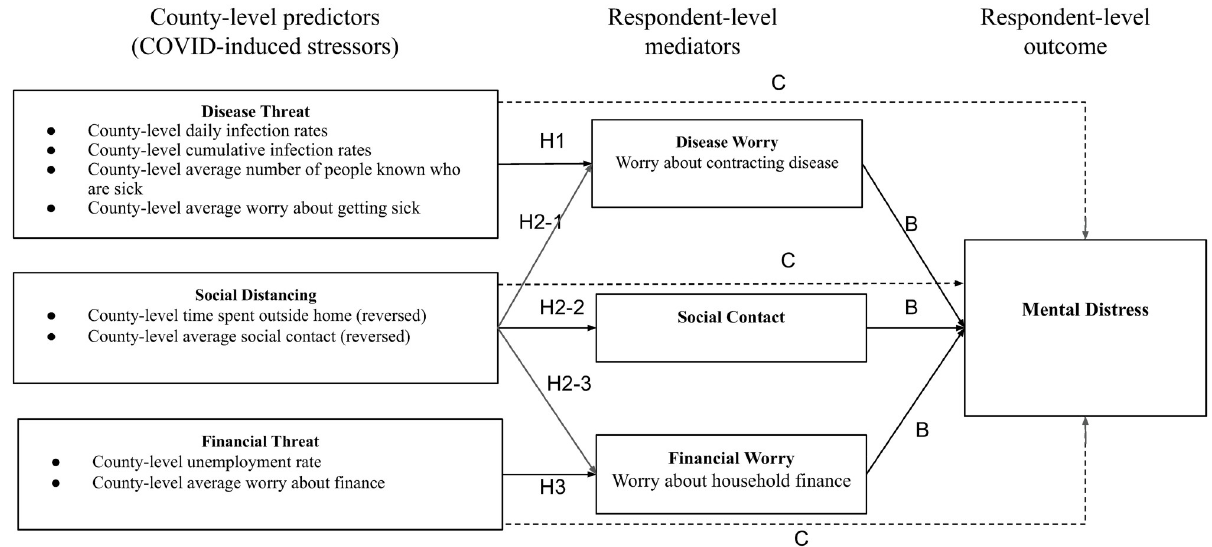
Fig 1. Predicted relationships among county-level COVID-related stressors, respondent-level mediators, and respondents’ mental distress.